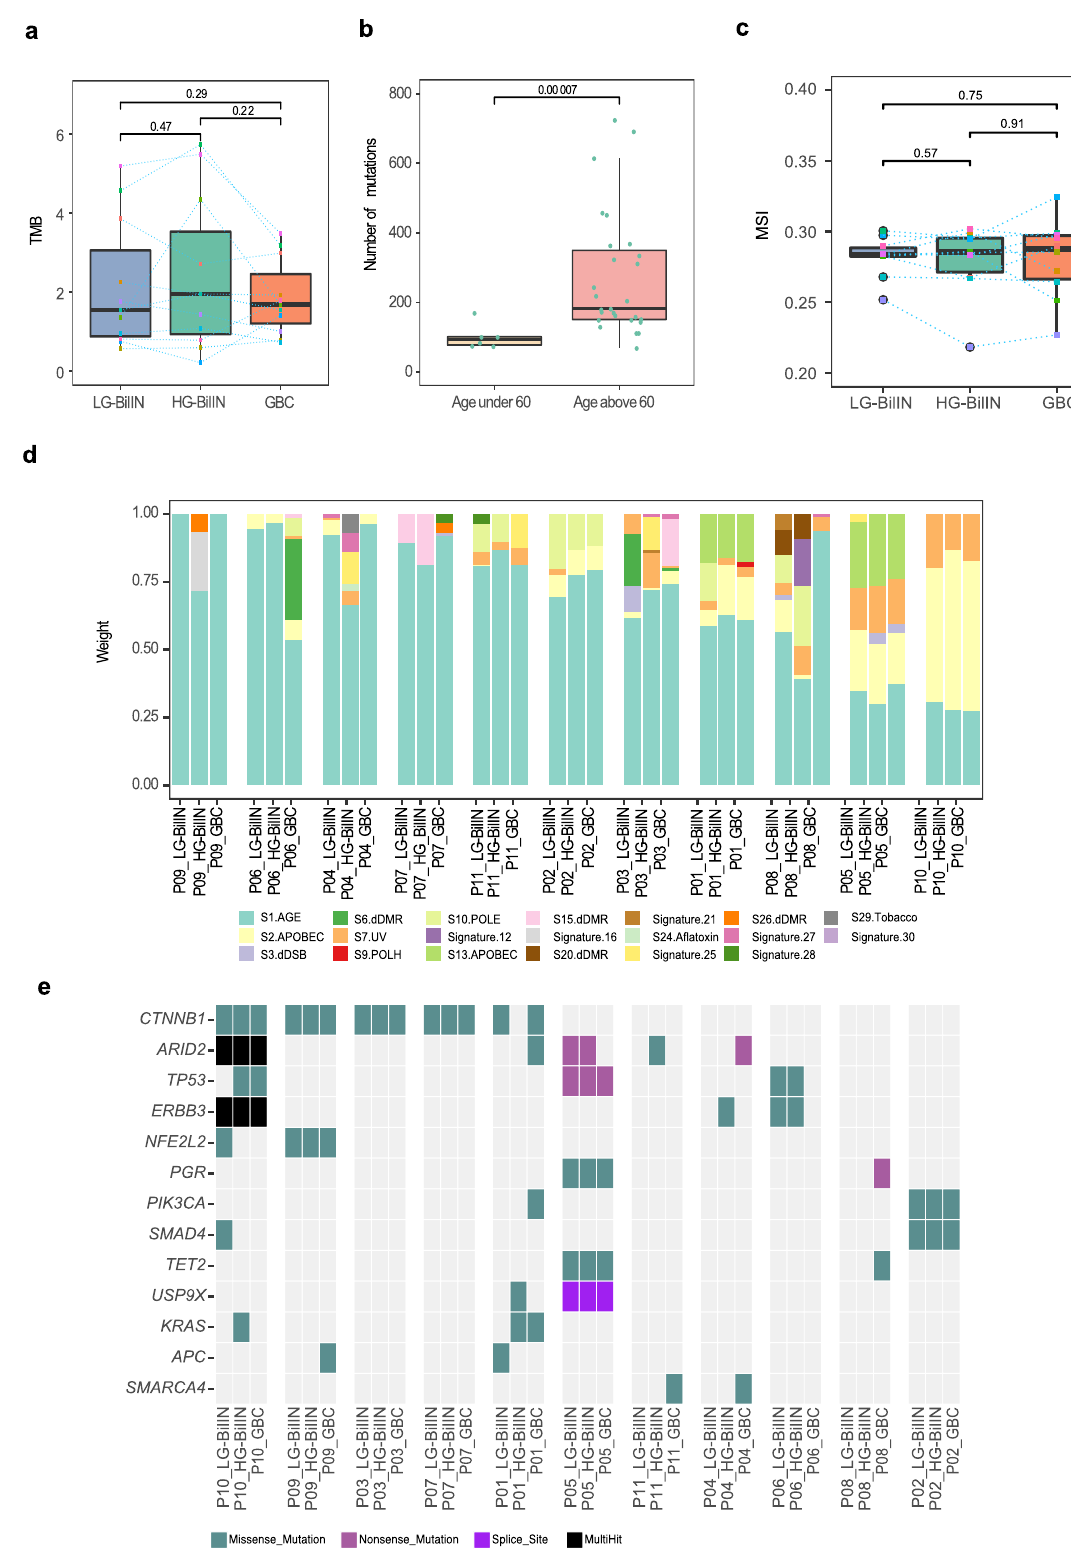
Fig. 2 Mutational feature comparison among three types of gallbladder tumors. a TMB distribution per tumor type ( n = 11 samples). b The number of mutations in tumor samples from young ( n = 6 samples) and old patients ( n = 27 samples). c MSI score distribution per tumor type ( n = 10 samples). d Relative contributions of different mutational signatures (annotated by etiology factors) in tumor samples based on COSMIC mutational signature v2. e An oncoplot showing potential driver mutations detected in at least two patients. Mutations are colored according to different substitution types. a – c The middle line in the box is the median, the bottom, and top of the box are the fi rst and third quartiles, and the whiskers extend to 1.5× interquartile range of the lower and the upper quartiles, respectively. Raw p -values based on two-tailed Student ’ s t -test are